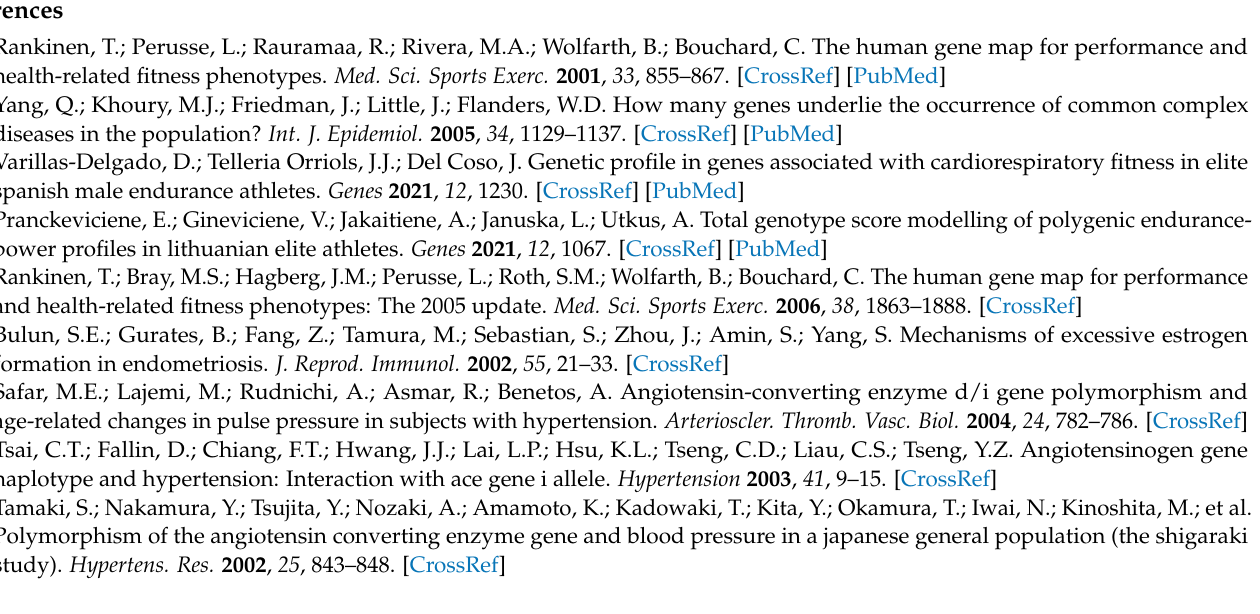
martial artists. Table S1. The main characteristics of the combatants of Group I and Group II; Table S2. Data on tested